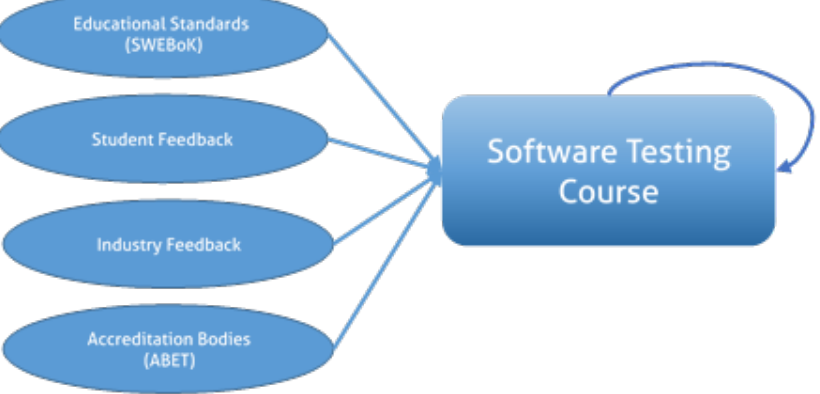
Fig. 1. Methodology to develop and improve the